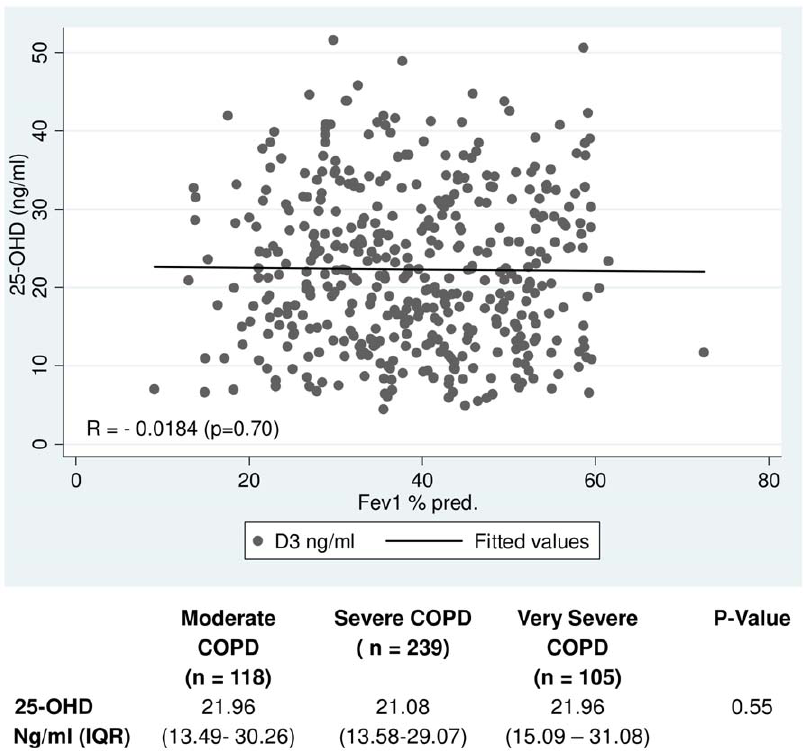
PLOS ONE | www.plosone.org